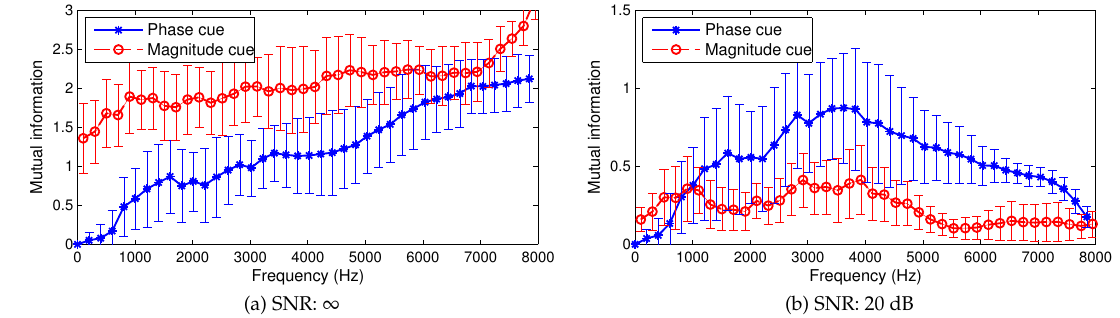
Figure 2. MI variation in spatial cues with respect to